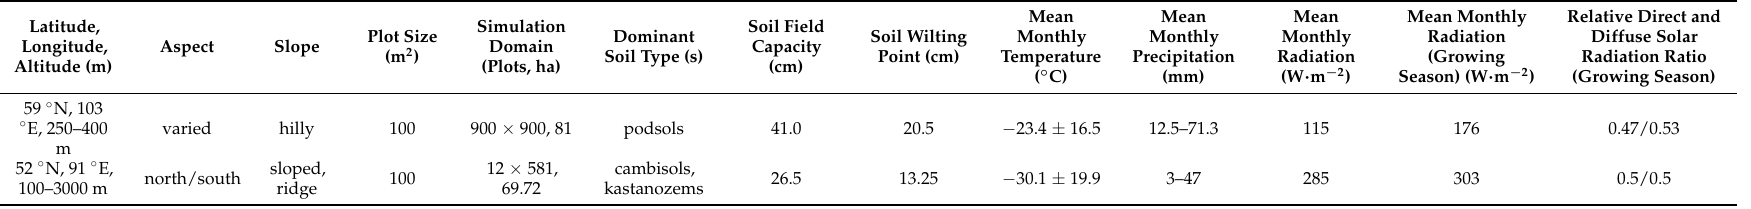
Table 4. Environmental conditions at middle and southern taiga sites within the boreal forest in central Siberia. Top row: topographic, climatological and edaphic conditions near Severny leshoz; bottom row: topographic, climatological and edaphic conditions near Kyzyl, in Republic of Tyva, in southern Alay-Sayan mountain